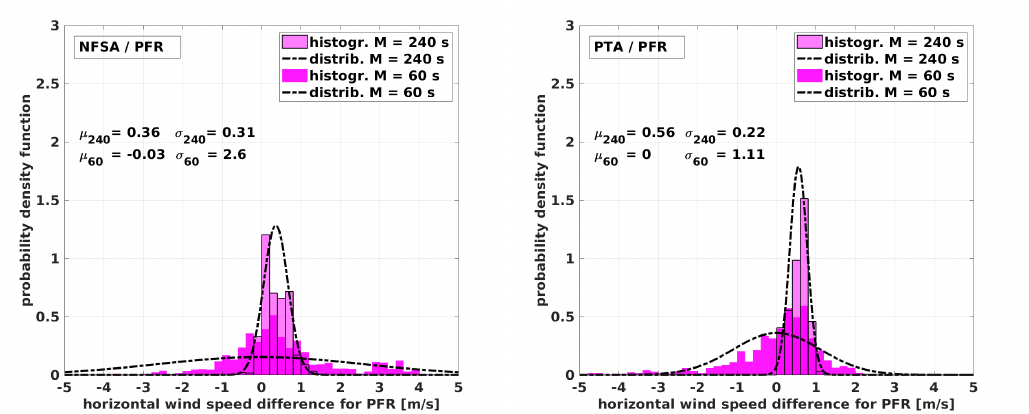
Figure 17. Normalized distribution and probability density function with the fitted normal distribution for the flight near Pforzheim ( PFR ). The plots show the deviation between the MHPA and the NFSA ( left ) and the MHPA and the PTA ( right ) for M = 240 s and for M = 60